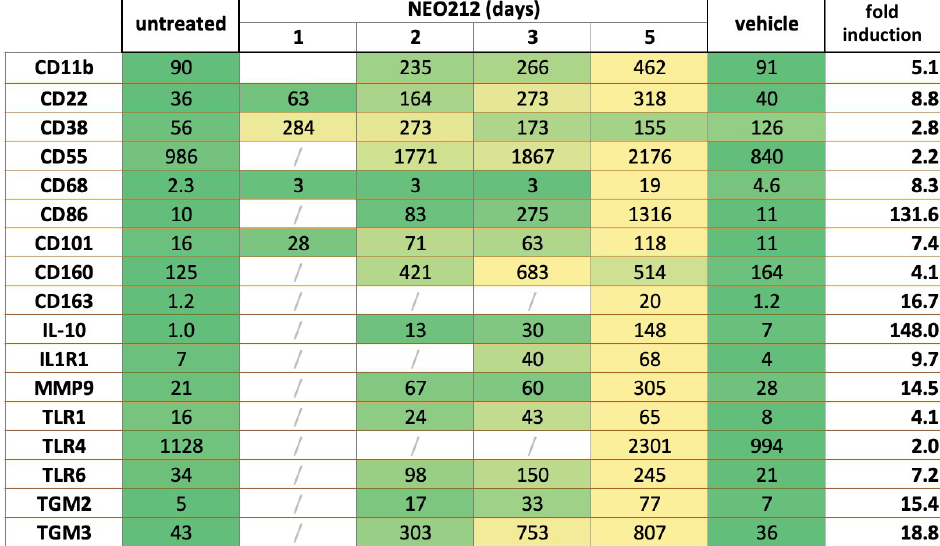
Figure 5. NEO212 stimulates expression of macrophage differentiation markers. AraC-resistant 6D10 cells were treated with 30 µM NEO212, harvested after 1, 2, 3, and 5 days, and processed for RNA-seq analysis. Comparator cell cultures were untreated cells or cells treated with vehicle DMSO for 5 days. Right column (fold induction) refers to the fold increase of the respective transcript after 5 days of drug treatment, as compared to untreated cells. Heatmap: green color shows pre-treatment levels and yellow color indicates an increase.